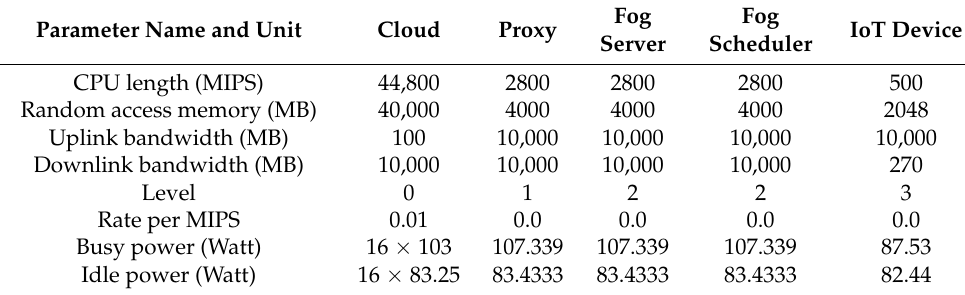
Table 4. Value of parameters used for cloud- and fog-based implementations [24].